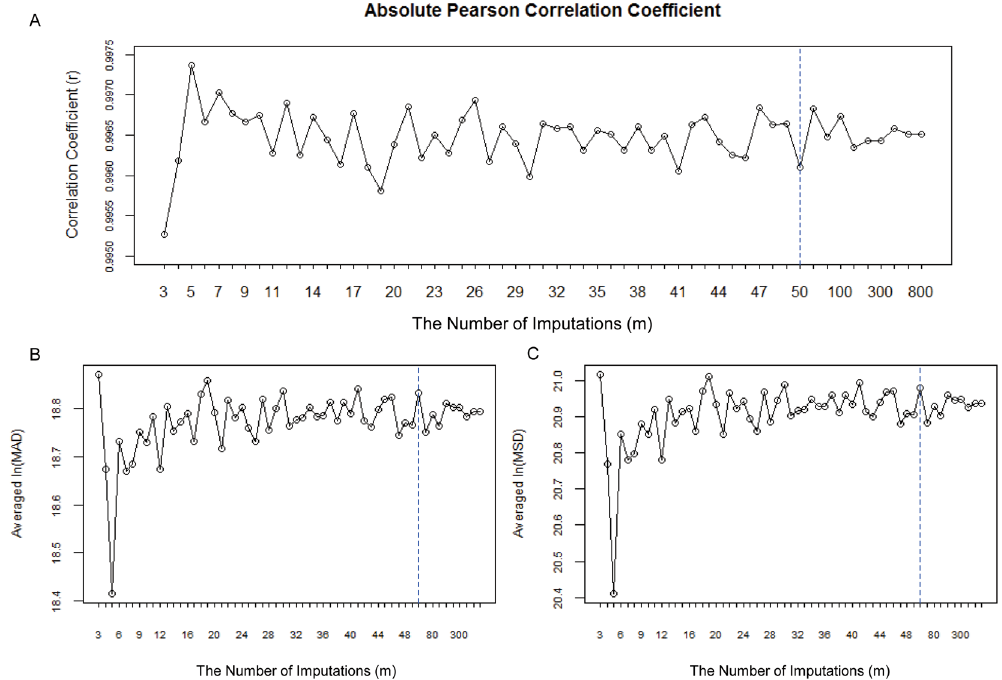
Figure 3. Line charts of absolute Pearson correlation coefficient ( A ) as well as the averaged ln(MAD) ( B ) and ln(MSD) ( C ) in simulated dataset D0(a) with 5% missing value percentage. In each panel, the x axis represents the multiple imputation number (m). In the left side of the dotted line, the m is from 3 to 50 continuously. In the right side, m is 60, 80, 100, 150, 200, 250, 300, 400, 600 and 800,